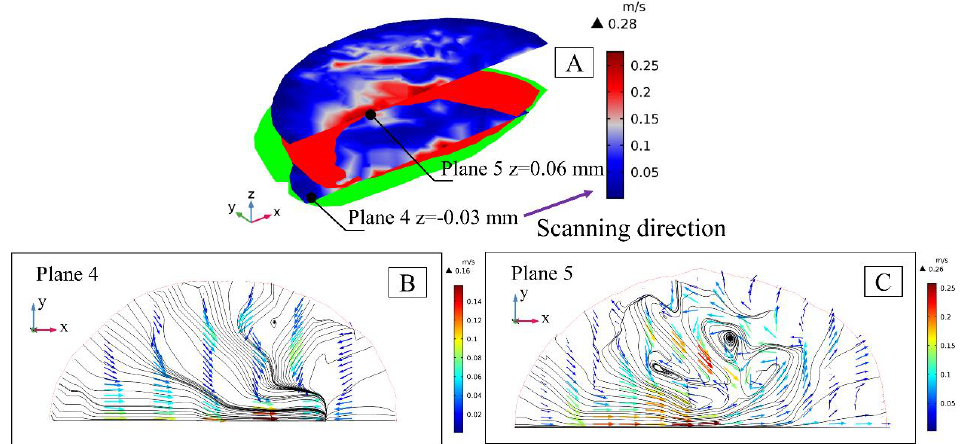
15 of 19 Figure 8. Melt pool profile, cross-section coordinates and velocity distribution on yz-plane. ( A ) Melt pool configuration and position of three yz-sections; ( B ) Velocity distribution at plane 1; ( C ) Velocity distribution at plane 2; ( D ) Velocity distribution at plane 3. Velocity evolution at the xy-planes inside the melt pool is plotted in Figure 9. To clearly illustrate the velocity field, the position of plane 5 is moved along the positive z- direction in Figure 9A. As shown in Figure 9 B,C, the streamlines are more concentrated and fluid flow is much more intense at plane 5 than that at plane 4 because surface tension mainly acts on a gas/liquid surface. Vortex motion is also observed at plane 5 and the streamlines are obviously dense near the symmetric plane, indicating flow is more intense in this area, which is also validated by the contour of the arrows representing the magni-